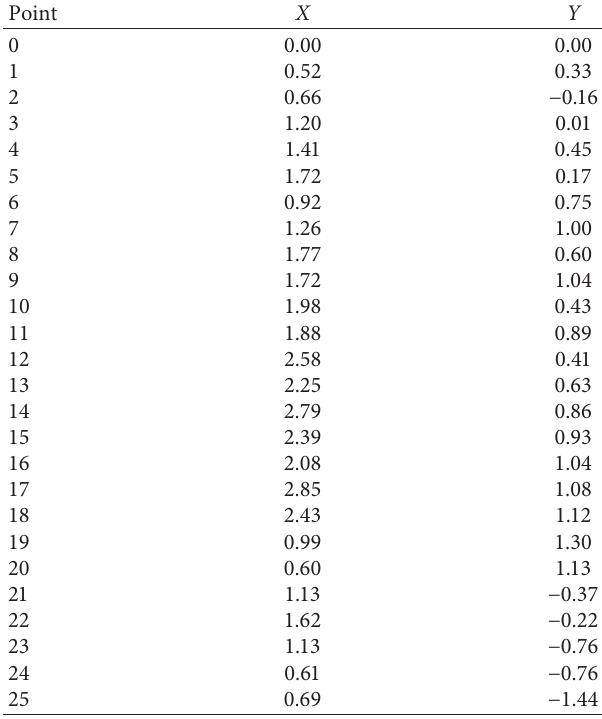
Figure 6: Possible service area and demand point distribution. Table 4: Coordinates of demand points